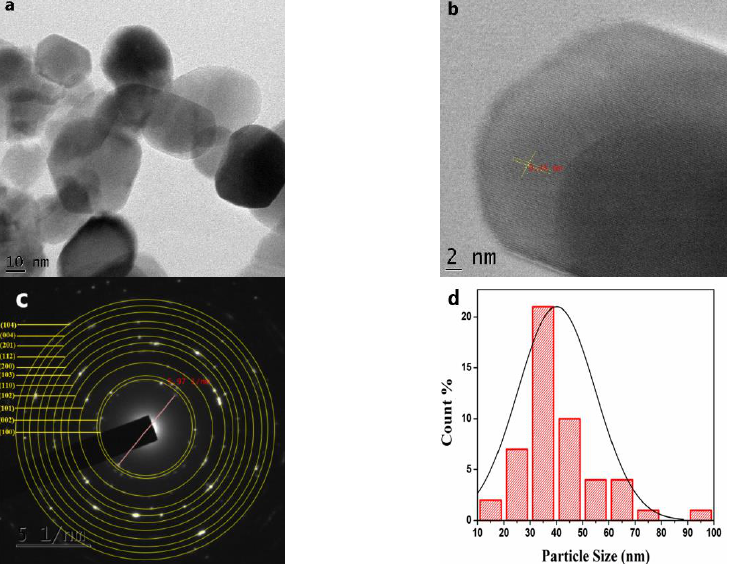
Figure 5. TEM data of ZnO NPs: ( a )TEM image; ( b ) HR-TEM image; ( c ) SAED pattern; ( d ) Histo- showing particle size distribution in the gram showing particle size distribution in the sample.